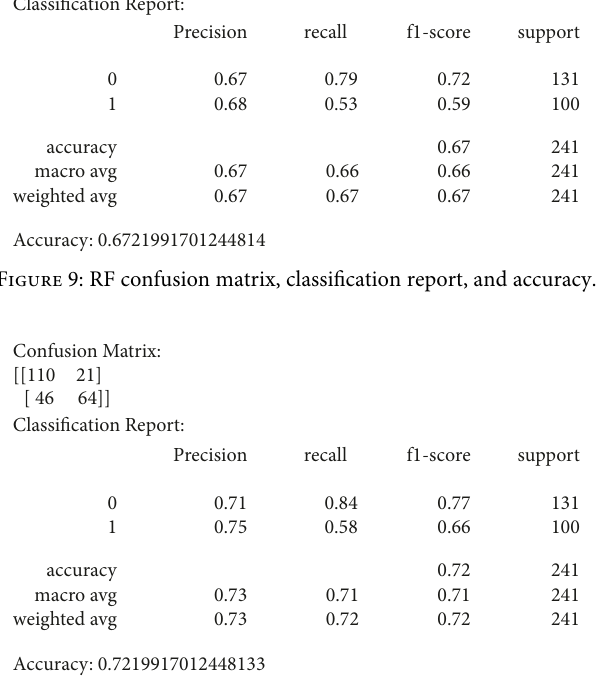
Figure 10: GB confusion matrix, classification report, and accuracy.